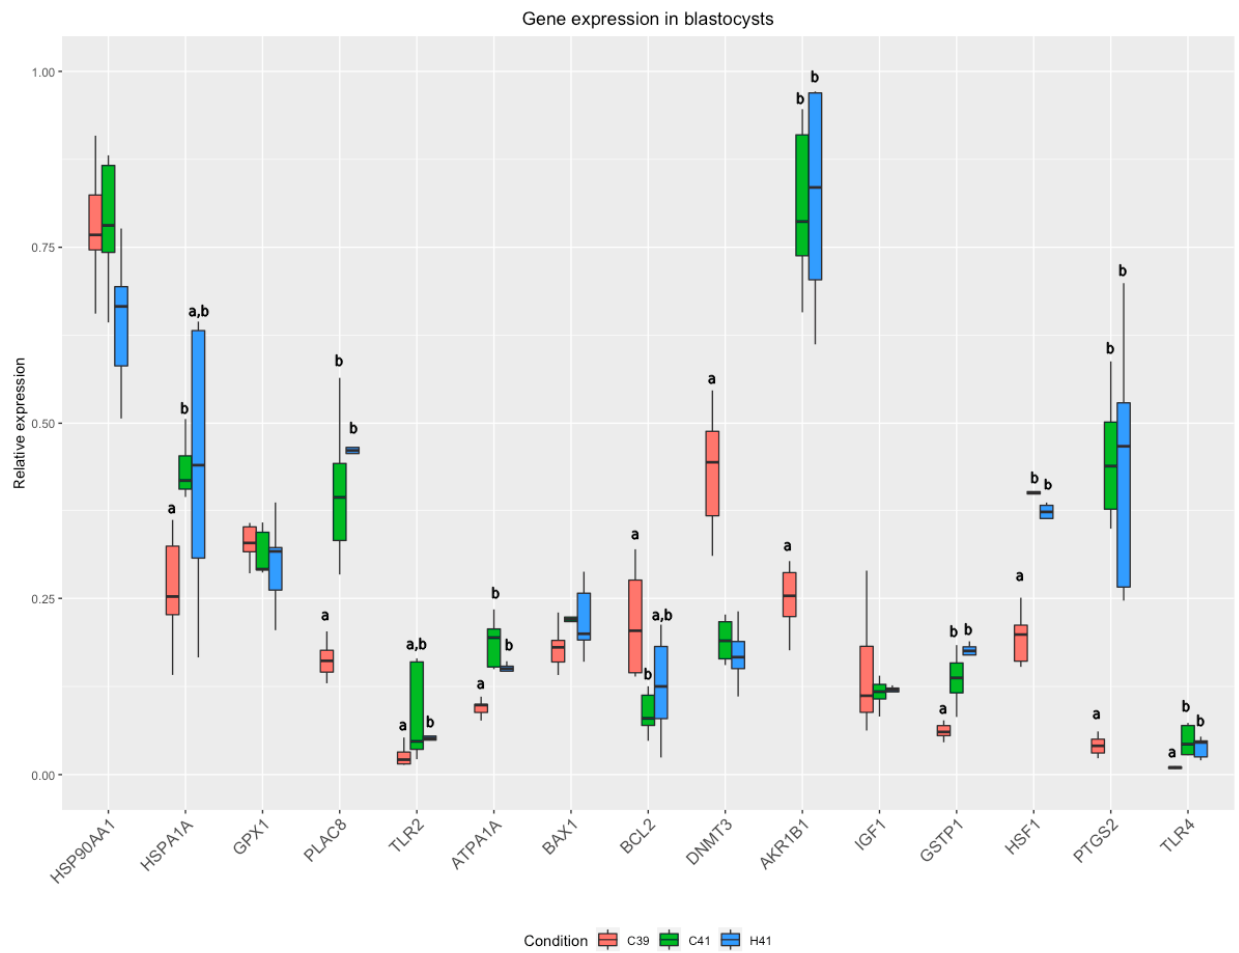
Figure 1. Gene expression in blastocysts cultured at 39 °C group (C39) or under raised temperature (41 °C) for 24 h in the absence (group C41) or the presence of HSP70 (group H41) in the culture medium. Within triplets, different letters denote significant changes (from the Kruskal-Wallis test and the ad-hoc Dunn test).